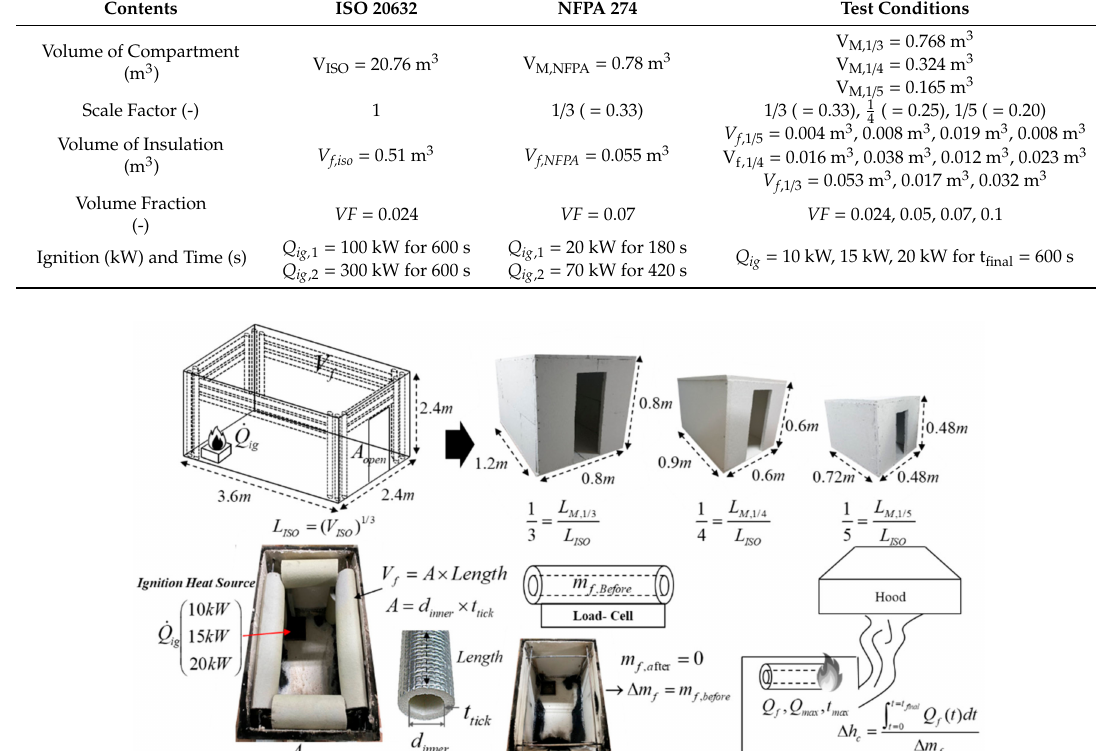
Table 1. Test conditions investigated by ISO 20632 and NFPA 274.